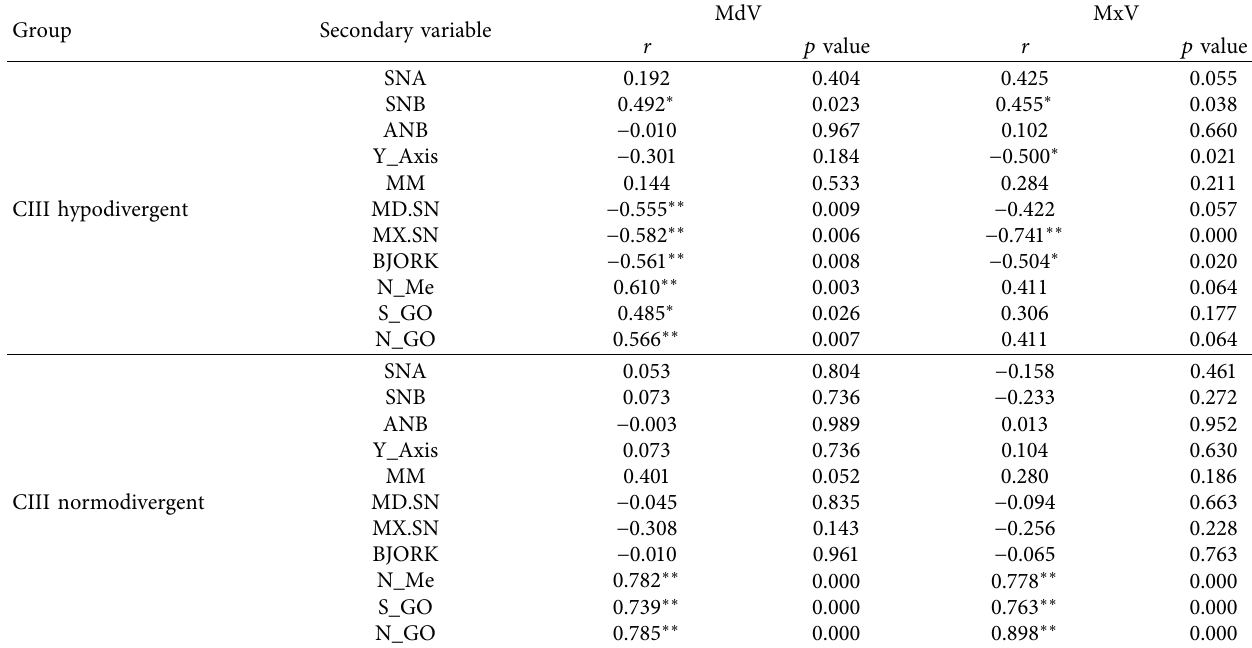
Table 5: Values of the correlation coefficients between 2D variables and the volumetric measurements in CIII hypodivergent and CIII normodivergent patients.